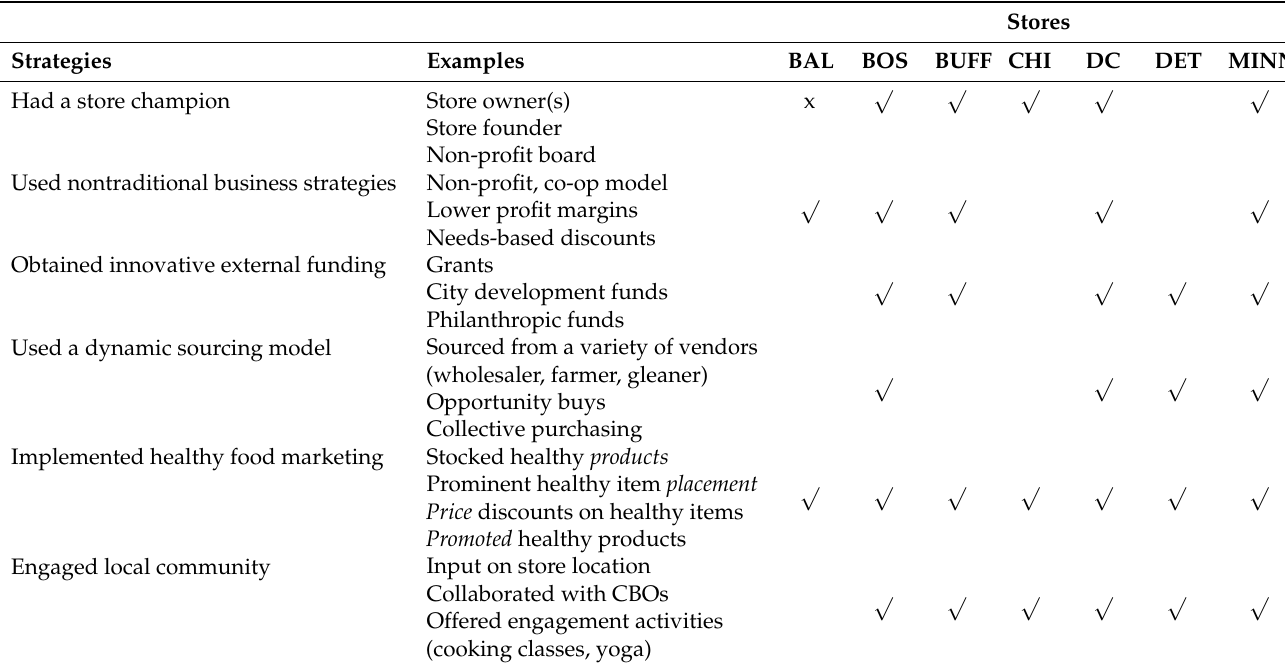
Table 3. Healthy community store success: strategies implemented by